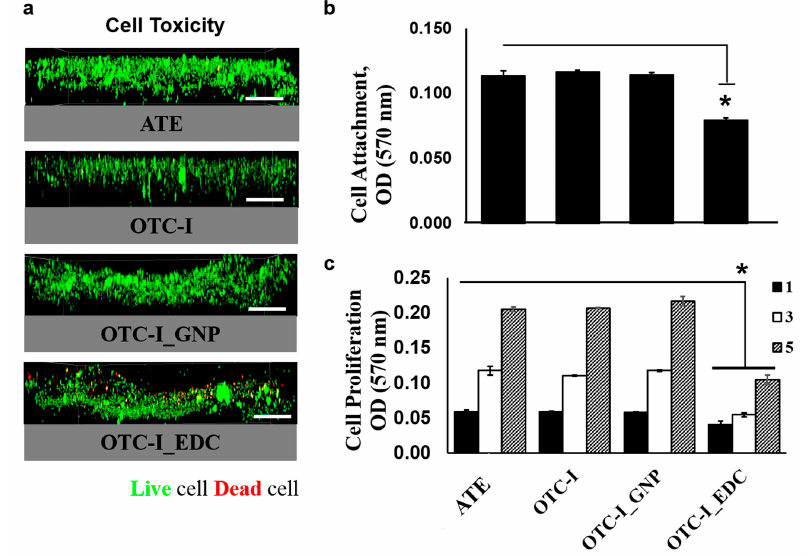
Figure 4. Immunochemical ( a ) and the HDF attachment ( b ) and growth pattern ( c ) of skin cells seeded on fabricated collagen bioscaffold at day 1, 3 and 5 (bar = 100 µm). The skin cells viability well-distributed